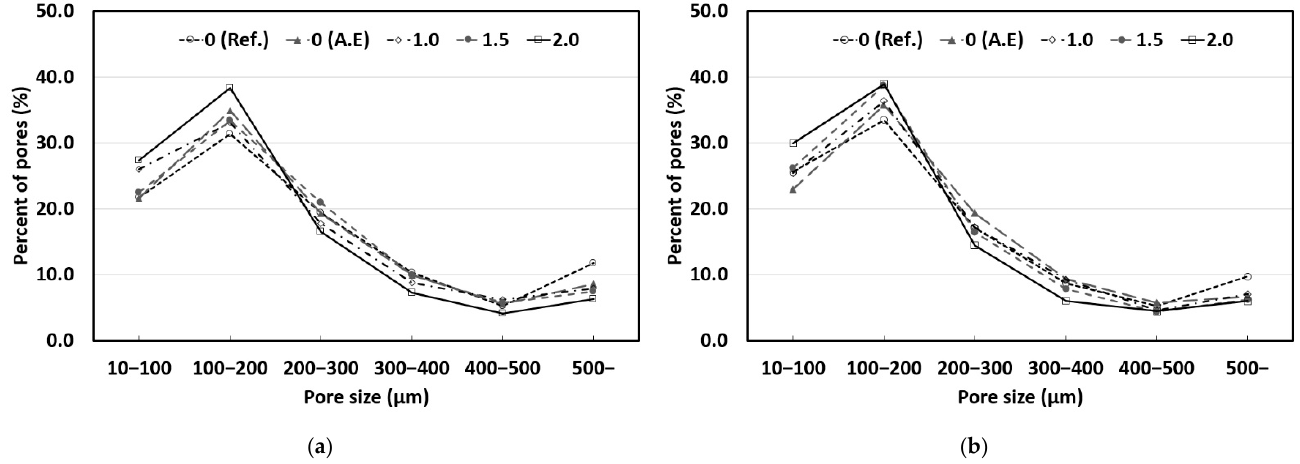
Figure 13. Results of pore size distribution (W/C 50%): ( a ) Sealed curing; ( b ) Water curing.